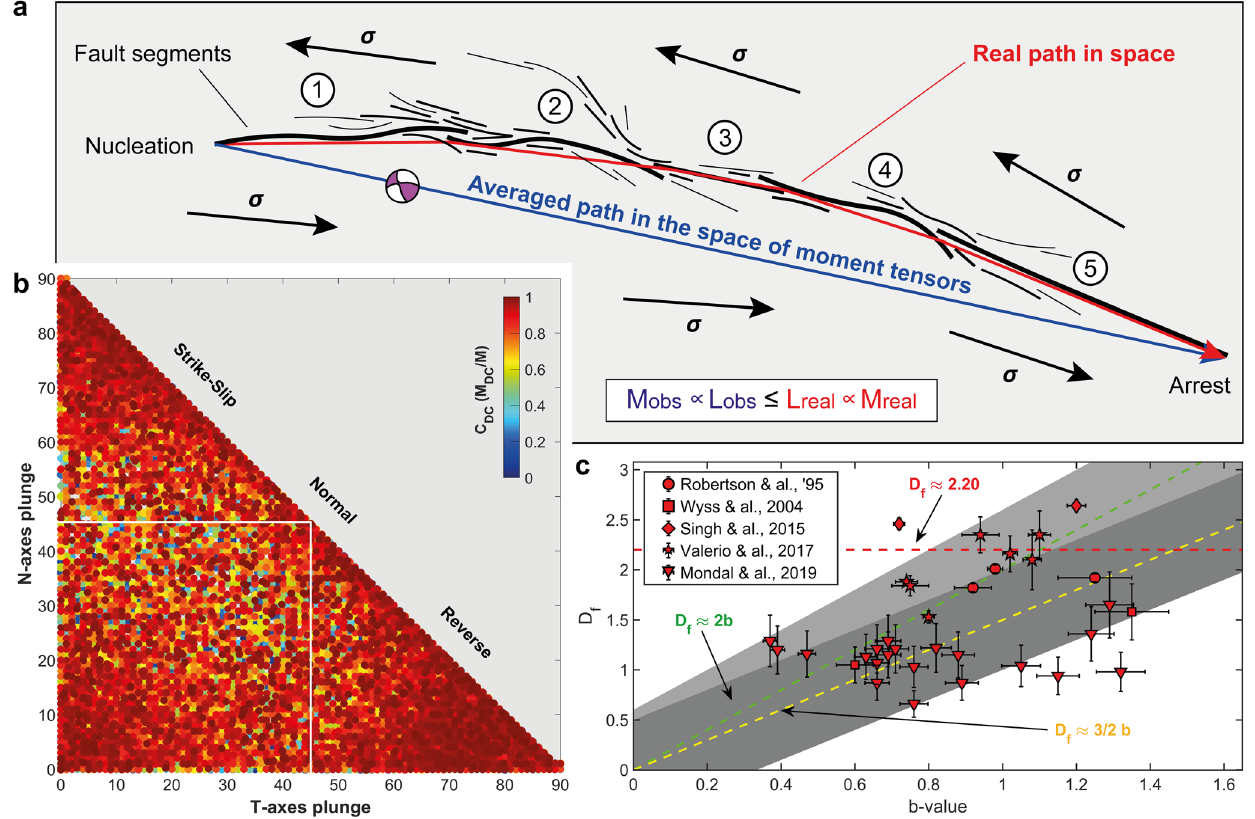
Fig. 9 A moment tensor and a focal mechanism are usually linked to each seismic event of large and moderate magnitude assuming the slip occurs on a planar fault. If the fracture involves several faults, the DC contribution decreases producing a large CLVD term, which is then a good proxy for the complexity of faulting. However, the attribution of a single moment tensor may imply an underestimation of the seismic moment of the earthquake if the fault slip involves several fault patches with different orientations ( a ). The degree of complexity of the fault rupture can be simply characterized looking at the DC contribution of the moment tensor, which seems to differ as a function of the tectonic setting ( b , data from ISC Catalogue) accordingly with the well-known positive correlation between the fractal dimension of the hypocentres time series and b -value ( c , data from 32, 65 – 68 , error bars from 32, 65, 66 , estimated using the ranges of values in 67 assuming uniform distributions and computed from 68 following methods described in Section 4 and references